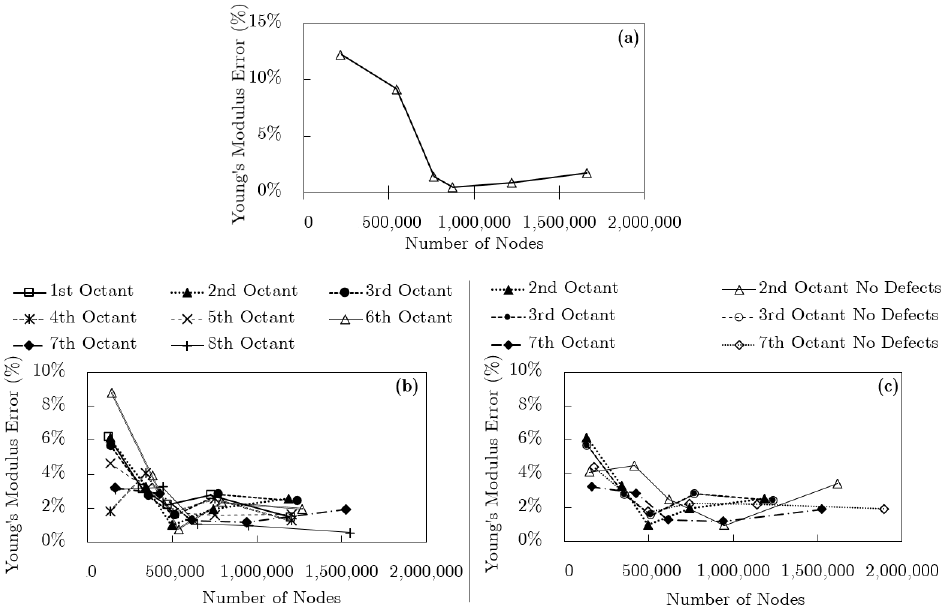
Figure 14. Convergence analysis of the error of the Young’s modulus for the ( a ) open-cell specimen, ( b ) closed-cell foam specimen prepared with Procedure 1 and ( c ) closed-cell foam specimen Procedure 2 (no defects) compared with Procedure